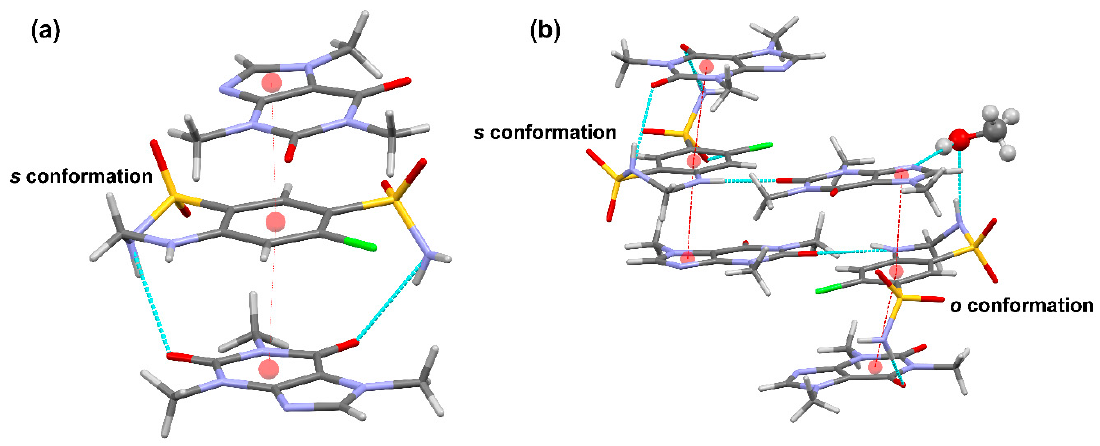
Figure 5. π − π stacking interactions in the HCT-CAF cocrystal ( a ) and its methanol solvate ( b ) structures.